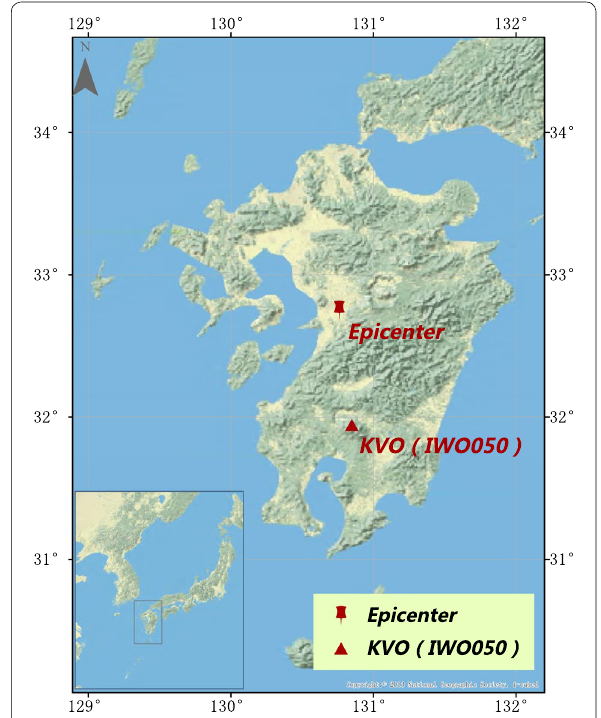
Fig. 1 Locations of the epicenter and observation stations KVO and IWO050. The red pentagram indicates the epicenter, whereas the red triangle indicates the seismic station KVO and the MT station